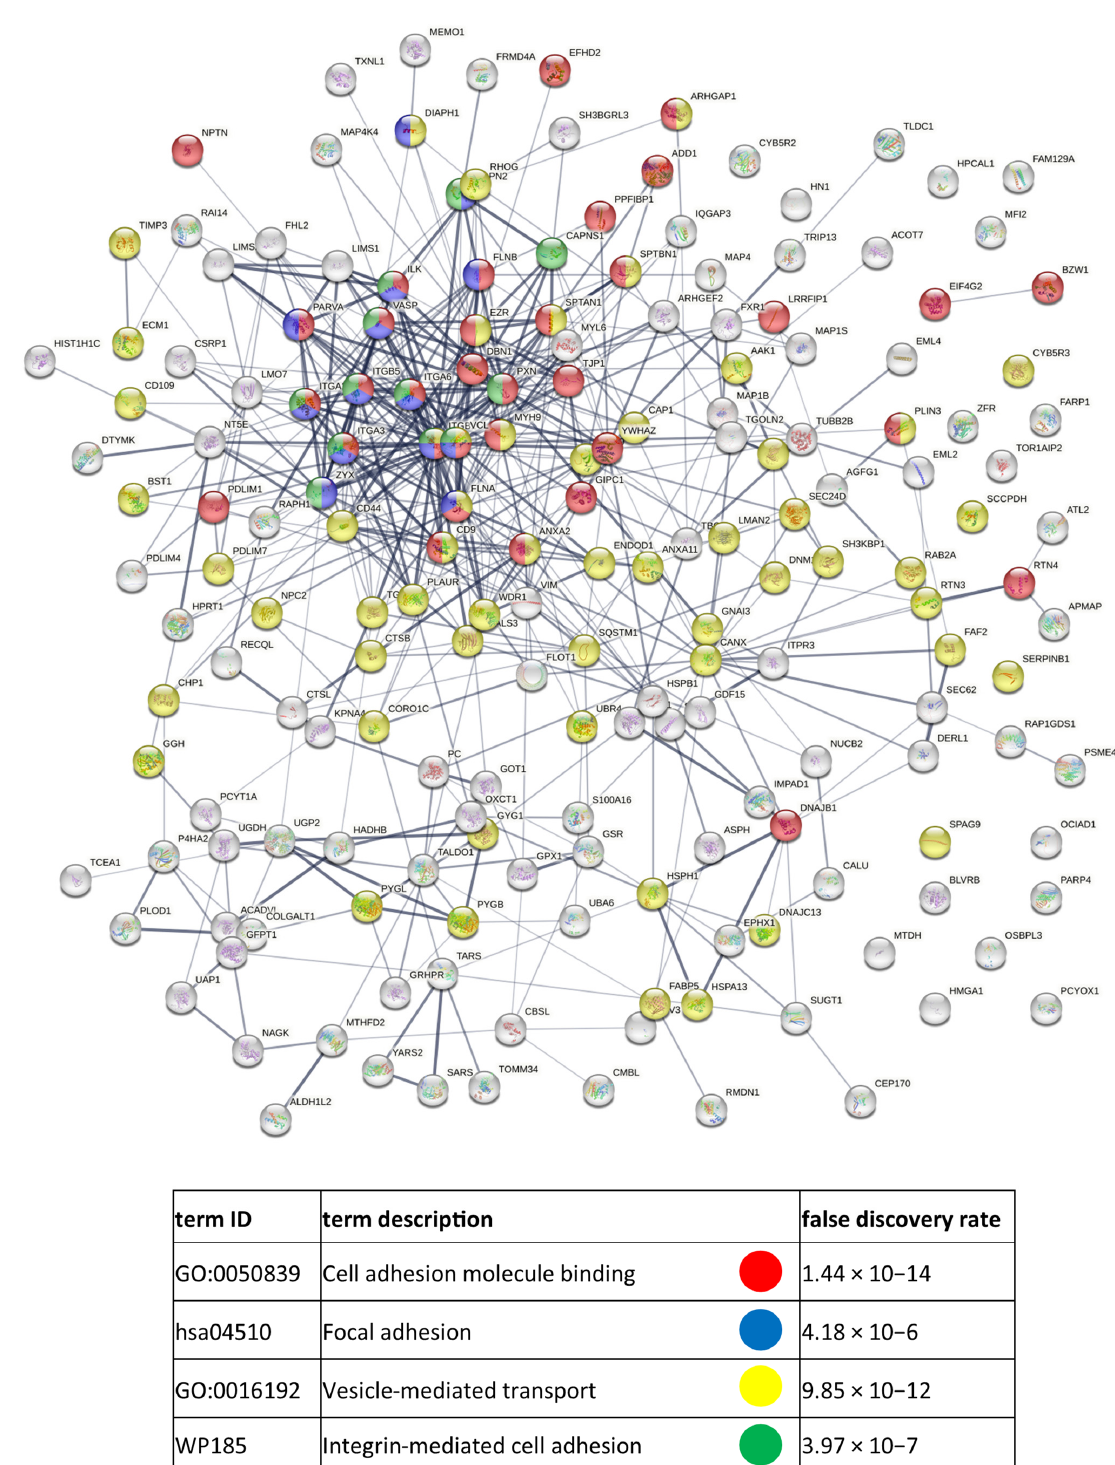
Figure A9. Diagram of functional protein association networks prepared with the use of STRING v. 11.0 software for proteins upregulated in WM1205Lu cells vs. WM793 cells. The selected, strongly represented pathways are presented as an interactome. Proteins with fold change > 1.5 were considered upregulated in WM1205Lu cells ( p < 0.001). A complete analysis is presented in Supplementary Data